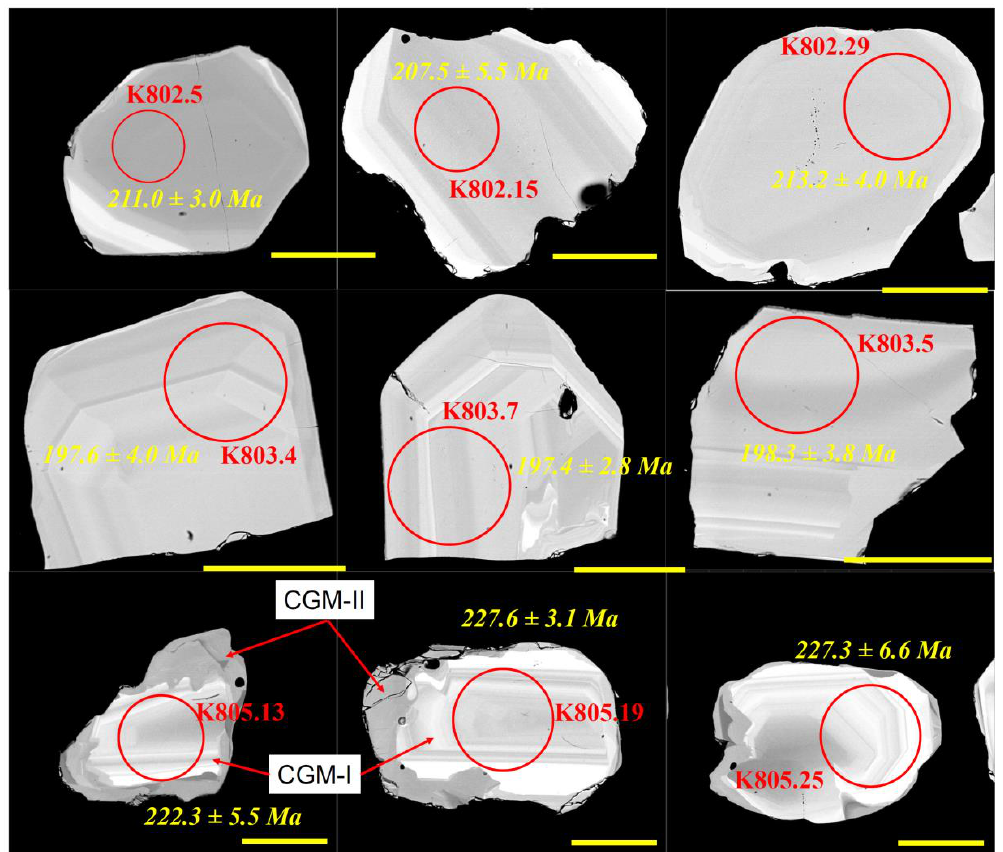
Figure 5. BSE images of representative CGM grains from No. 802, No. 803, and No. 805 pegmatites at Kalu’an in the Chinese Altay orogen. The red circles represent the positions of ablation pits during LA-ICP-MS dating and the relevant apparent 206 Pb/ 238 U ages are shown next to individual ablation pits. All the scale bars are 50 μm long. pits. All the scale bars are 50 µ m long.